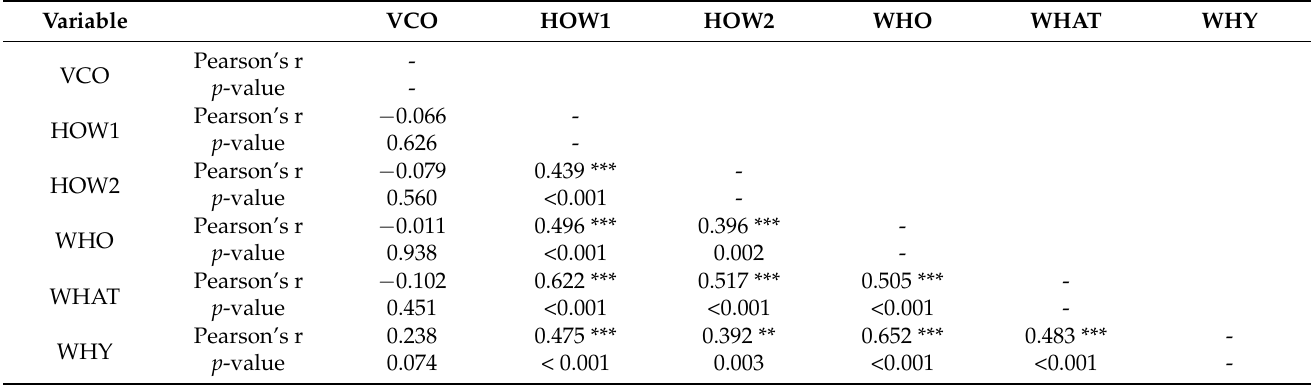
Figure 2. BM CEDIS.E in 2020. Own depiction as per CEDIS.E ( n = 57). Table 2. Relationships between the BM elements of CEDIS.E.